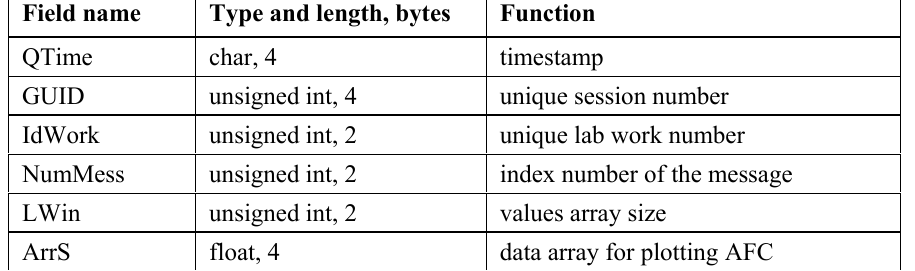
Table 2. Server response to client